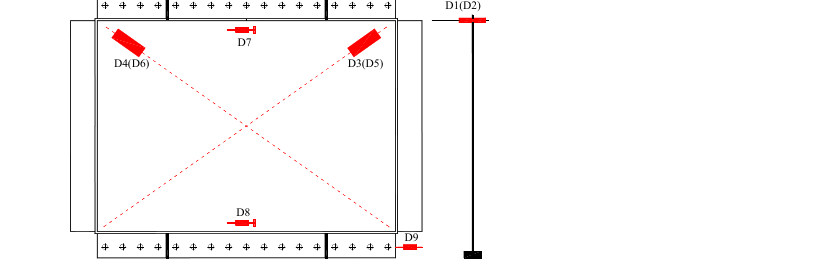
Figure 4. Arrangement of the LVDTs. Note: The displacement range of D1–D6 was 100 mm, and that of D7–D9 was 50 mm.